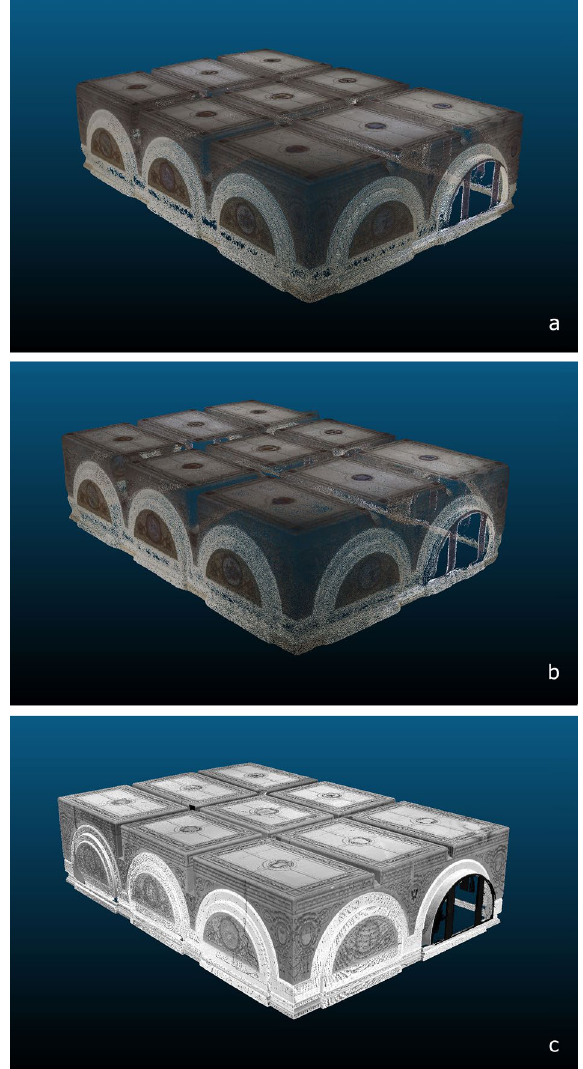
Figure 3 . Point Cloud of the Hall of Caltanissetta Centrale Station acquired with (from top to bottom): Insta360 ONE R in 4K wide-angle elaborated in Agisoft Metashape (a) and eyesCloud3d (b), Leica HDS7000 (c).